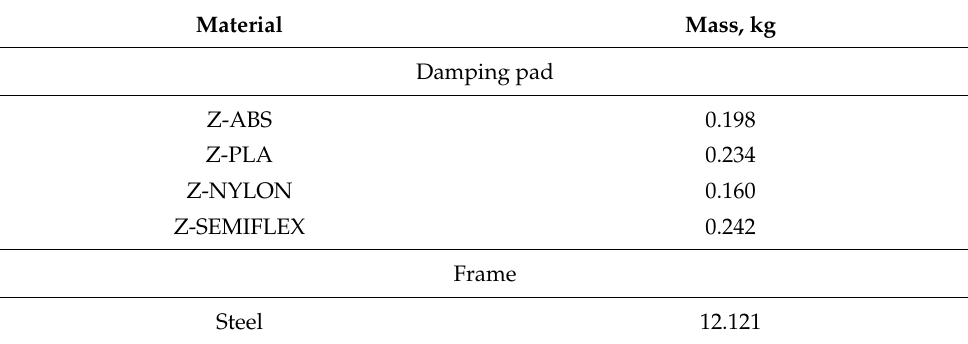
Table 2. Mass of subsequent damping pads and steel frame.